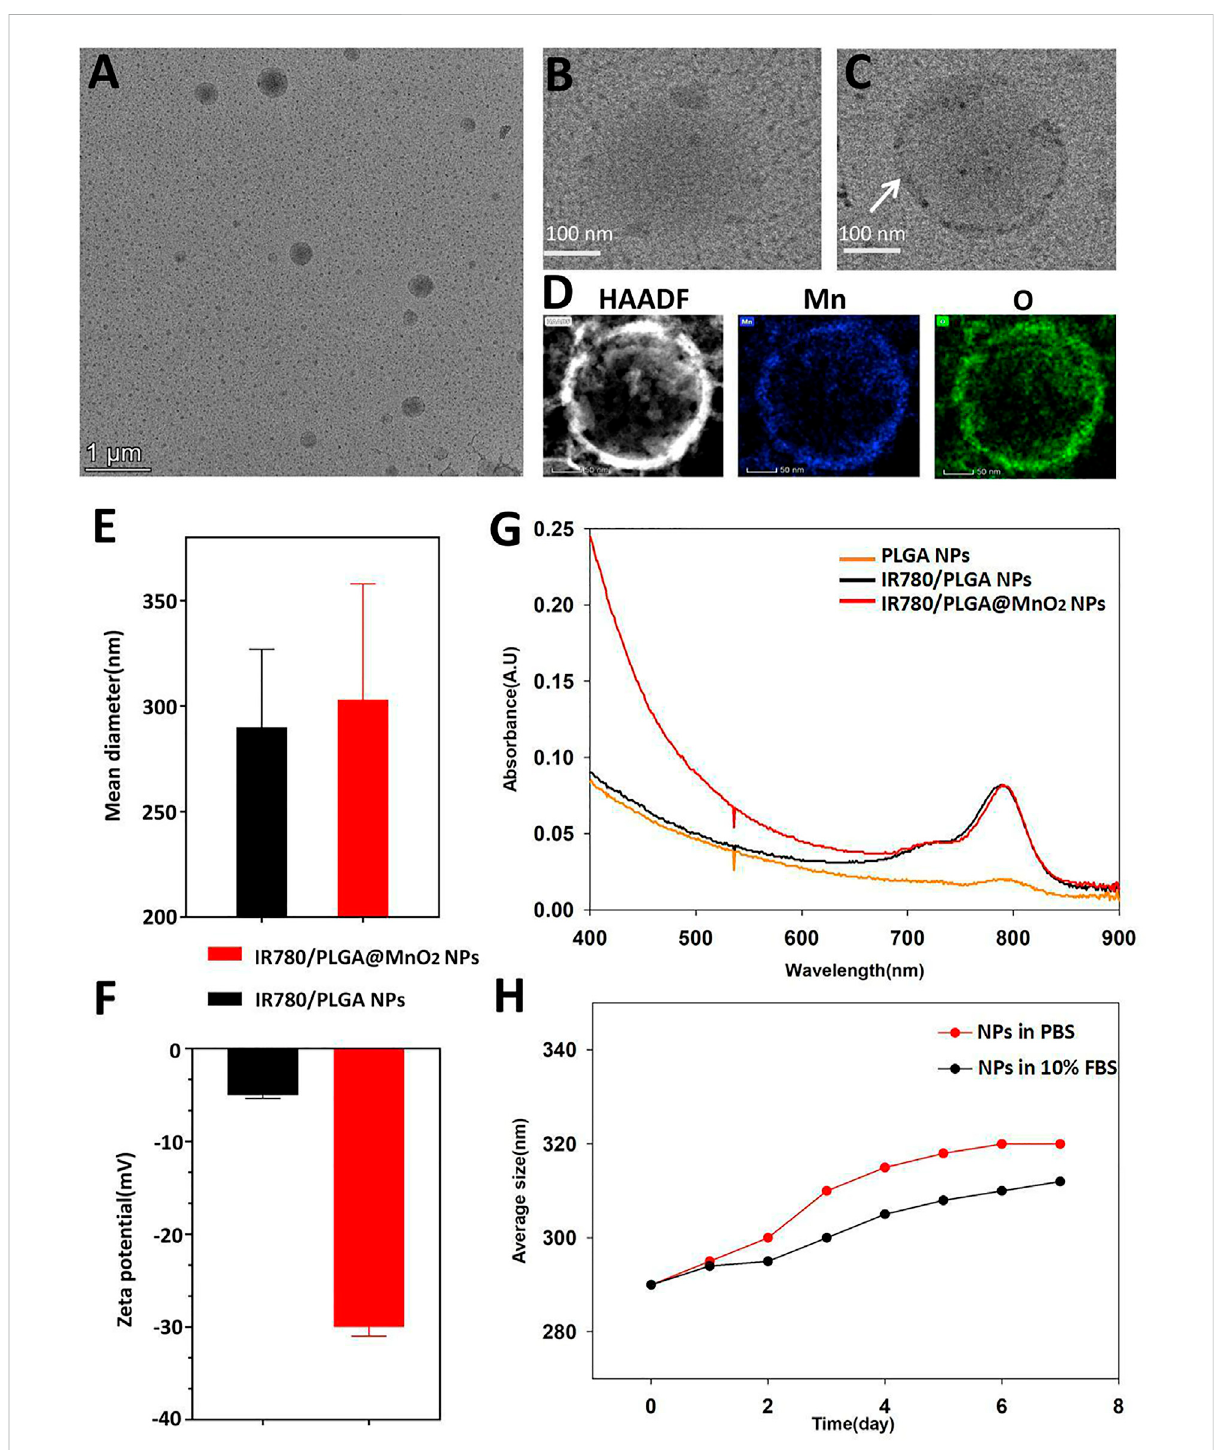
FIGURE 2 Characterization of IR780/PLGA@MnO 2 NPs. (A – C) The TEM images of IR780/PLGA@MnO 2 NPs (A) and IR780/PLGA NPs (B) , the white arrow indicated theMnO 2 on the shell of IR780/PLGA@MnO 2 NPs (C) . (D) The elemental mapping of Mn and O of IR780/PLGA@MnO 2. (E) Size and (F) zeta potential of IR780/PLGA NPs with and without MnO 2 shell. (G) UV − vis − NIR absorption spectra of IR780/PLGA NPs, PLGA NPs, IR780/PLGA@MnO